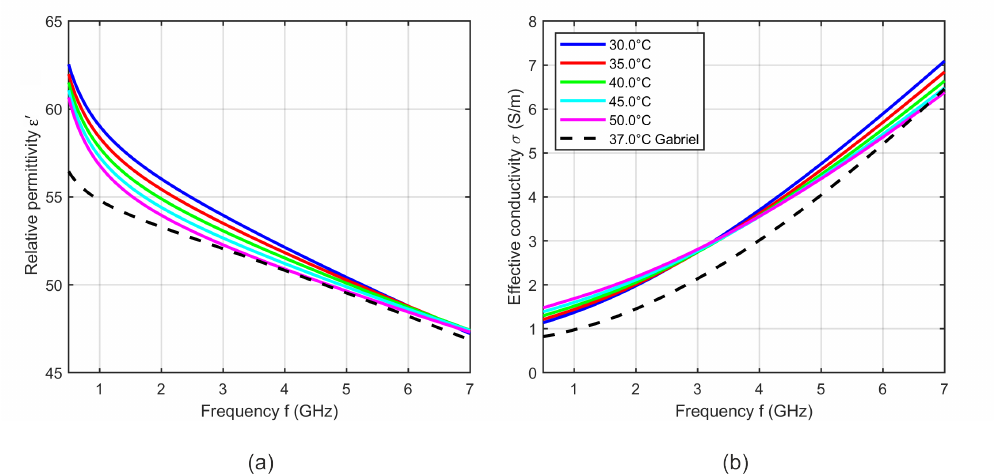
Figure 11. ( a ) Relative permittivity and ( b ) effective conductivity of porcine muscle as a function of frequency at different temperatures. Black curves show the dielectric properties of muscle reported by Gabriel [31] at 37 ◦